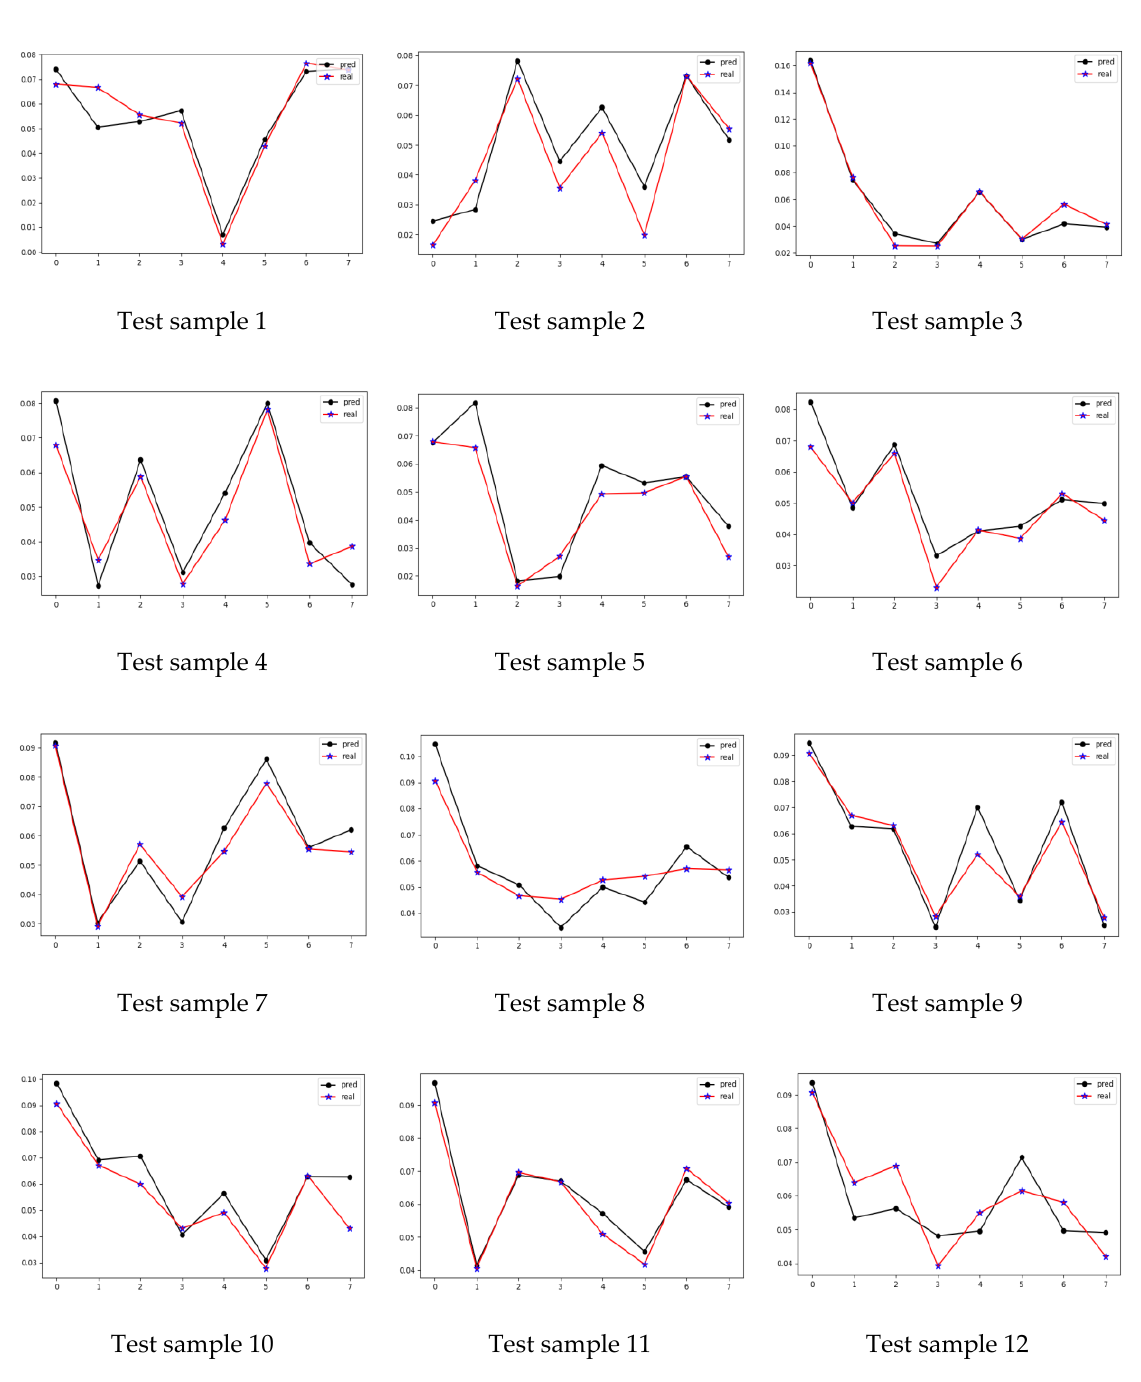
Figure 13. Coaxiality prediction network prediction effect graph.